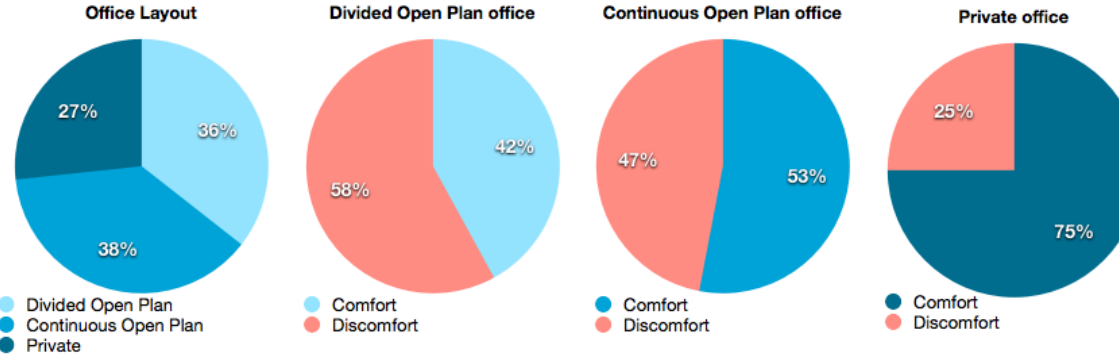
Figure 5. People occasionally feeling discomfort correlated with the office